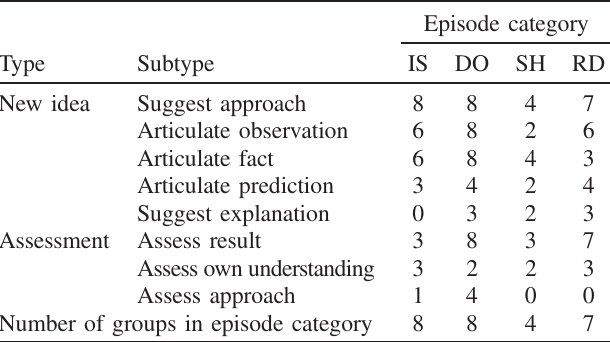
TABLE I. Metacognitive moves. Shown are the numbers of groups engaging in dialogue in which at least one conversational move was coded as metacognitive. Results are broken down by type and subtype of metacognitive move.